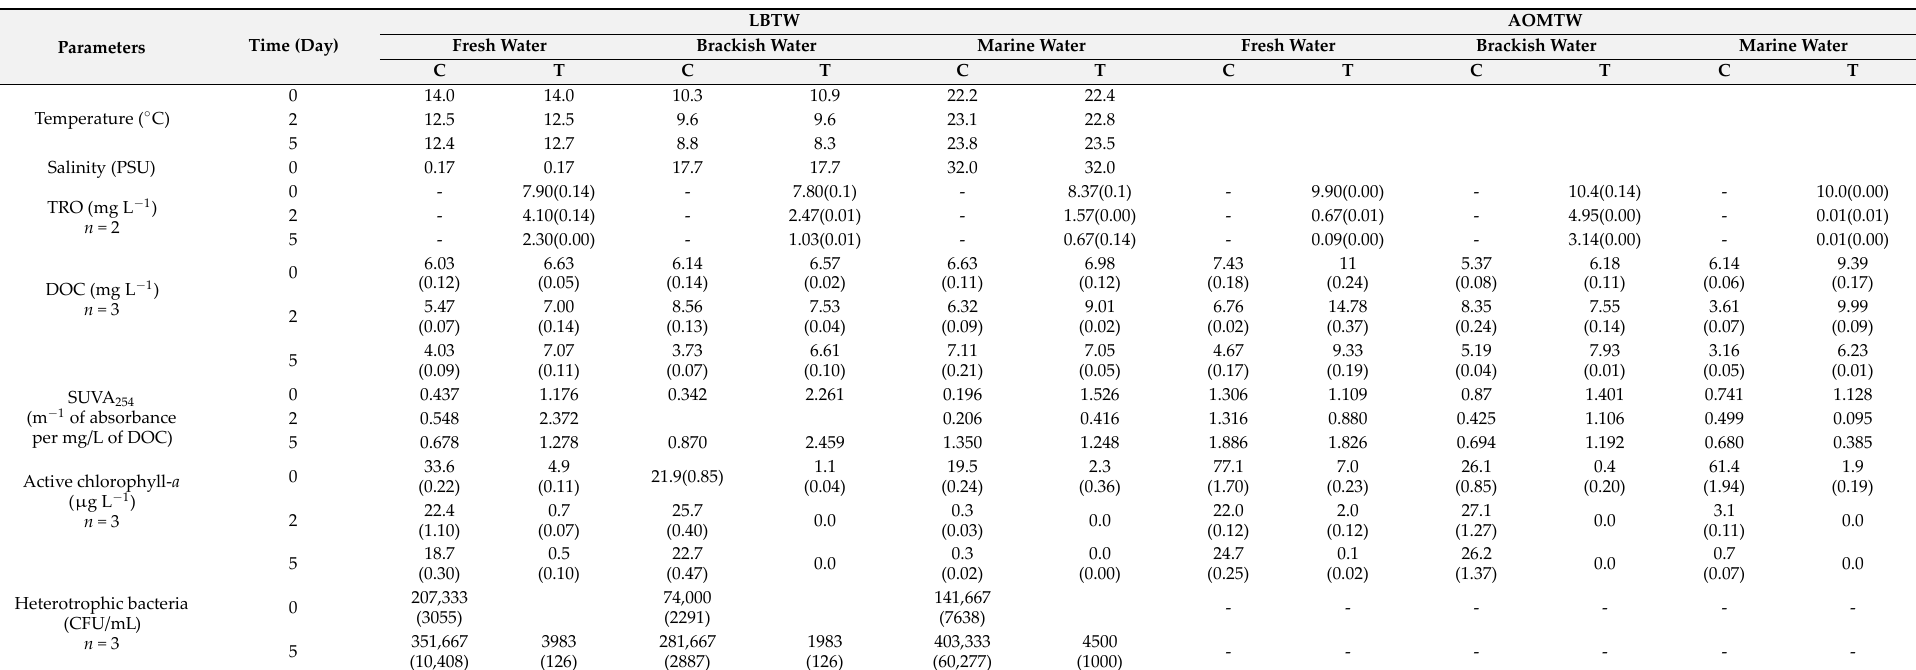
Table 4. Environmental parameters measured for the land‑based test water (LBTW) and algal organic matter test water (AOMTW) in control (C) and treated (T) water (The values presented in the table are mean values, and the values in parentheses are standard deviations.)